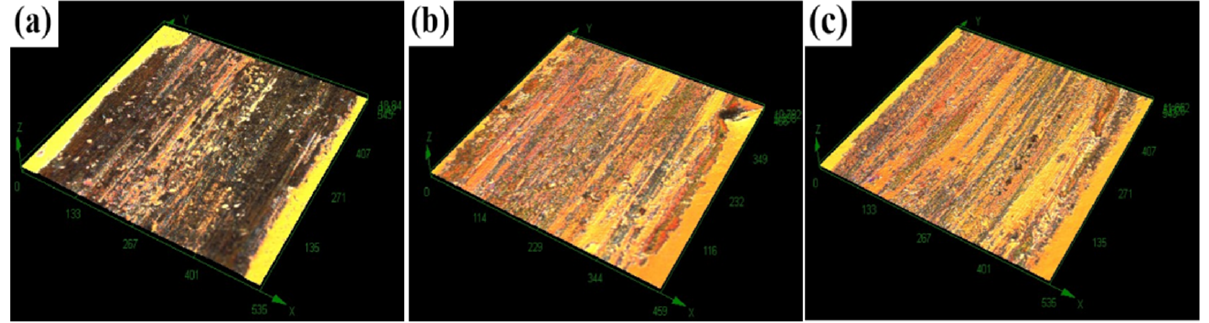
Figure 13. The 3D morphology of the wear area of samples treated by different processes—( a ) UT; ( b ) LQ; ( c ) LQ-LSP3.